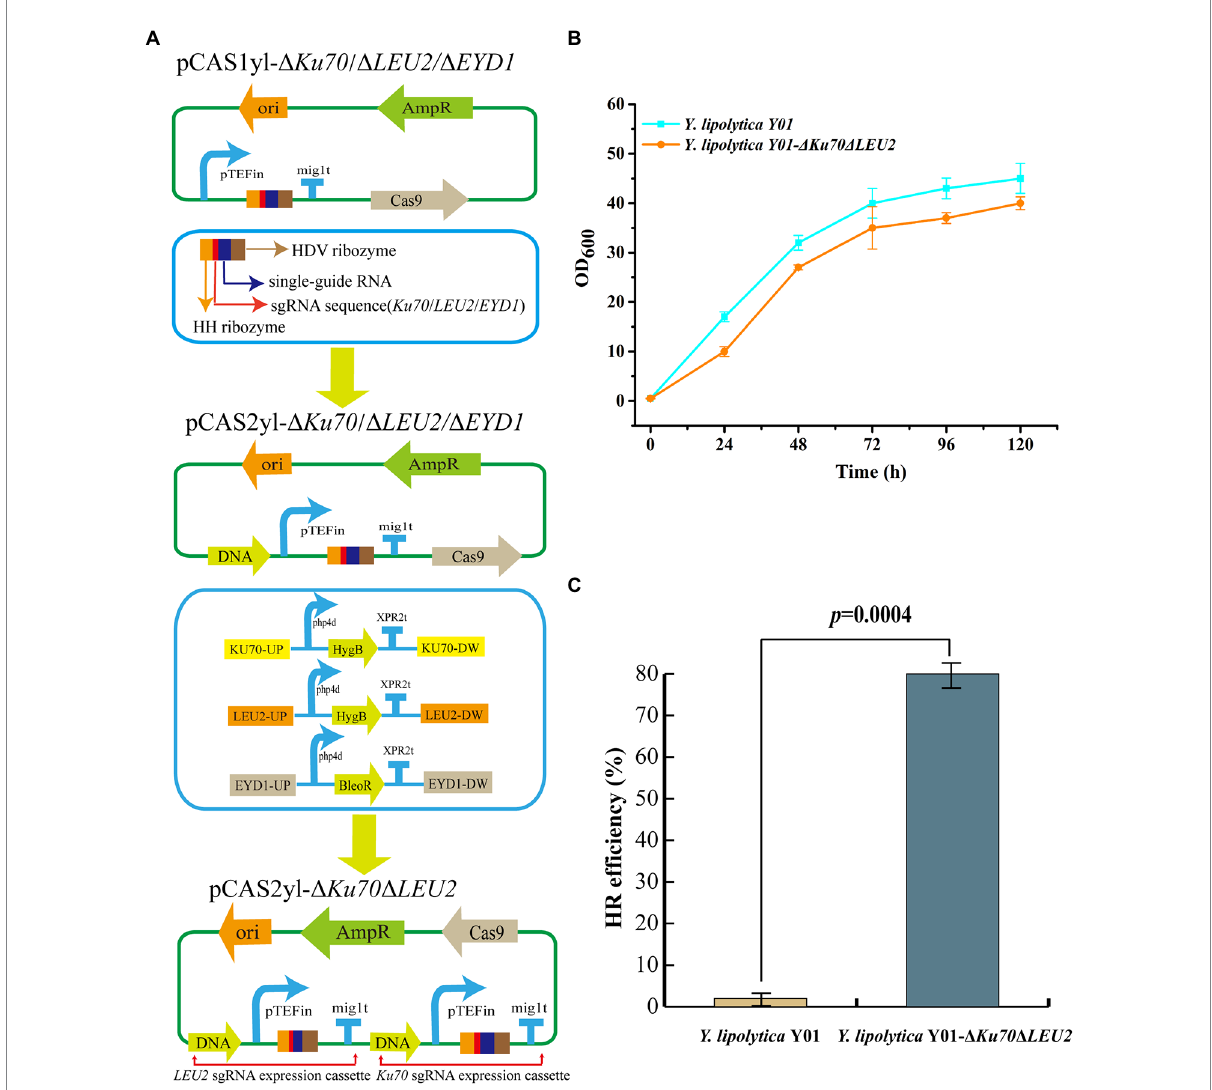
FIGURE 2 Influence of Ku70 and LEU2 knockout on strain growth and HR efficiency. (A) Construction of Ku70 and LEU2 knockout plasmids. pTEFin: Strong endogenous promoter; mig1t: Terminator; HDV ribozyme, single-guide RNA, single sequence and HH ribozyme were used to construct sgRNA expression cassette; DNA: Donor DNA. (B) Growth curves of Yarrowia lipolytica Y01 and Y. lipolytica Y01- Δ Ku70 Δ LEU2 strains. (C) Efficiencies of gene integration in Y. lipolytica Y01 and Y. lipolytica Y01- Δ Ku70 Δ LEU2 strains. Three biological replicates were used to obtain the data. The error bars represented the standard deviation. Significance ( p -value) was evaluated by two-sided t